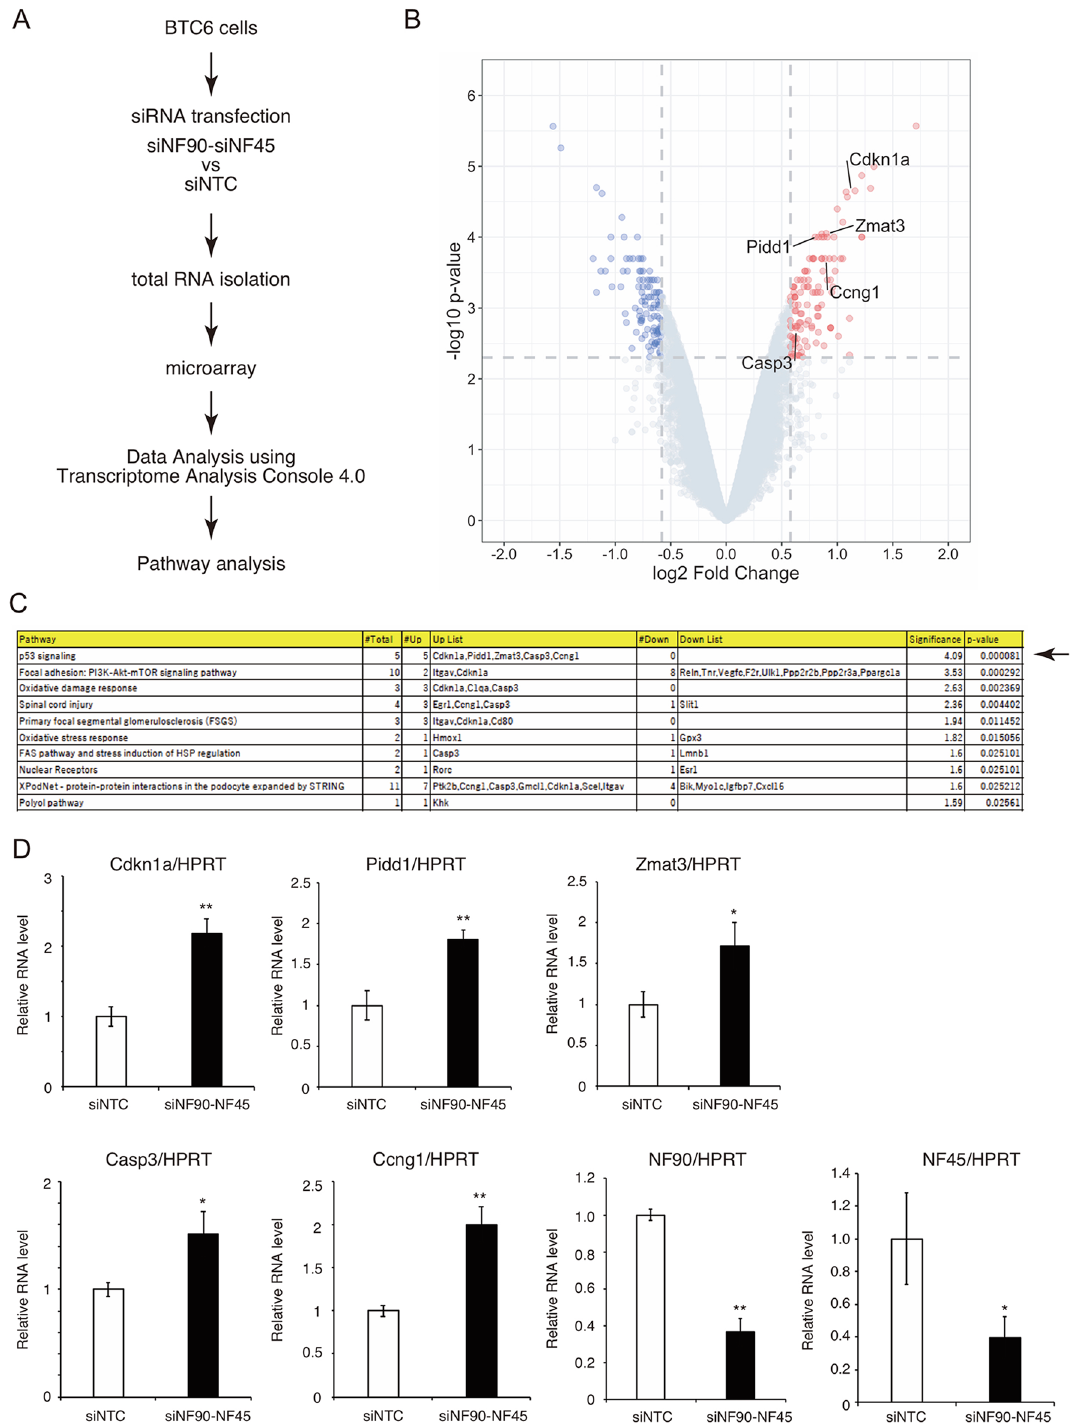
Figure 4. Pathway analysis in β cell lines depleted of NF90 and NF45. ( A ) Schema of an experimental procedure for microarray analysis. Total RNA was prepared from BTC6 cells treated with siNF90 and siNF45 for 7 days. ( B ) Volcano plots with ‘log2 Fold Change’ on the x-axis and ‘− log10 p-value’ on the y-axis reveal significant changes of genes that exhibited significantly different expression levels between siNTC-treated cells and siNF90–NF45-treated cells (values of p < 0.005, fold change of NF90–NF45-treated cells is > 1.5 and < − 1.5, respectively). > 1.5-fold-change, p < 0.005 and < − 1.5-fold-change, p < 0.005 were indicated as red and blue colours, respectively. ( C ) Wikipathway analysis using genes pathed the filter criteria mentioned above (> 1.5 or < − 1.5-fold change, P < 0.005) shown in ( A ). Top 10 pathways were shown as list in order of significance. An arrow indicates top-1 rank by this analysis. ( D ) qRT-PCR of 5-upragurated genes (Cdkn1a, Pidd1, Zmat3, Casp3 and Ccng3) in p53 signaling shown in ( C ) in siNTC- and siNF90– NF45-treated cells. The levels of NF90 and NF45 expression were also measured by qRT-PCR. HPRT was used as an internal control. Data are expressed as mean ± standard deviations. (n = 3 per group). * P < 0.05, **P < 0.01 relative to the siNTC-treated cells by a two-tailed Student’s t